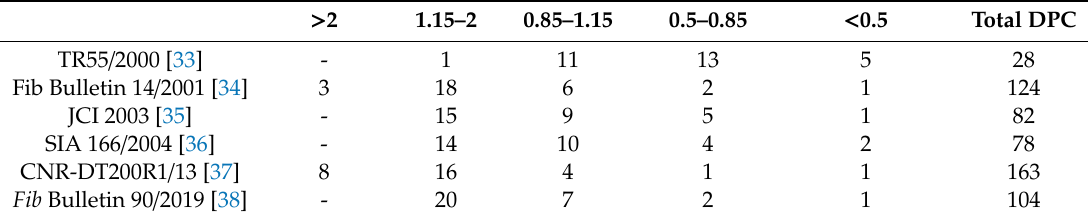
Table 10. Classification of technical guidelines according to Collins’ DPC scale; SRP composites bonded to